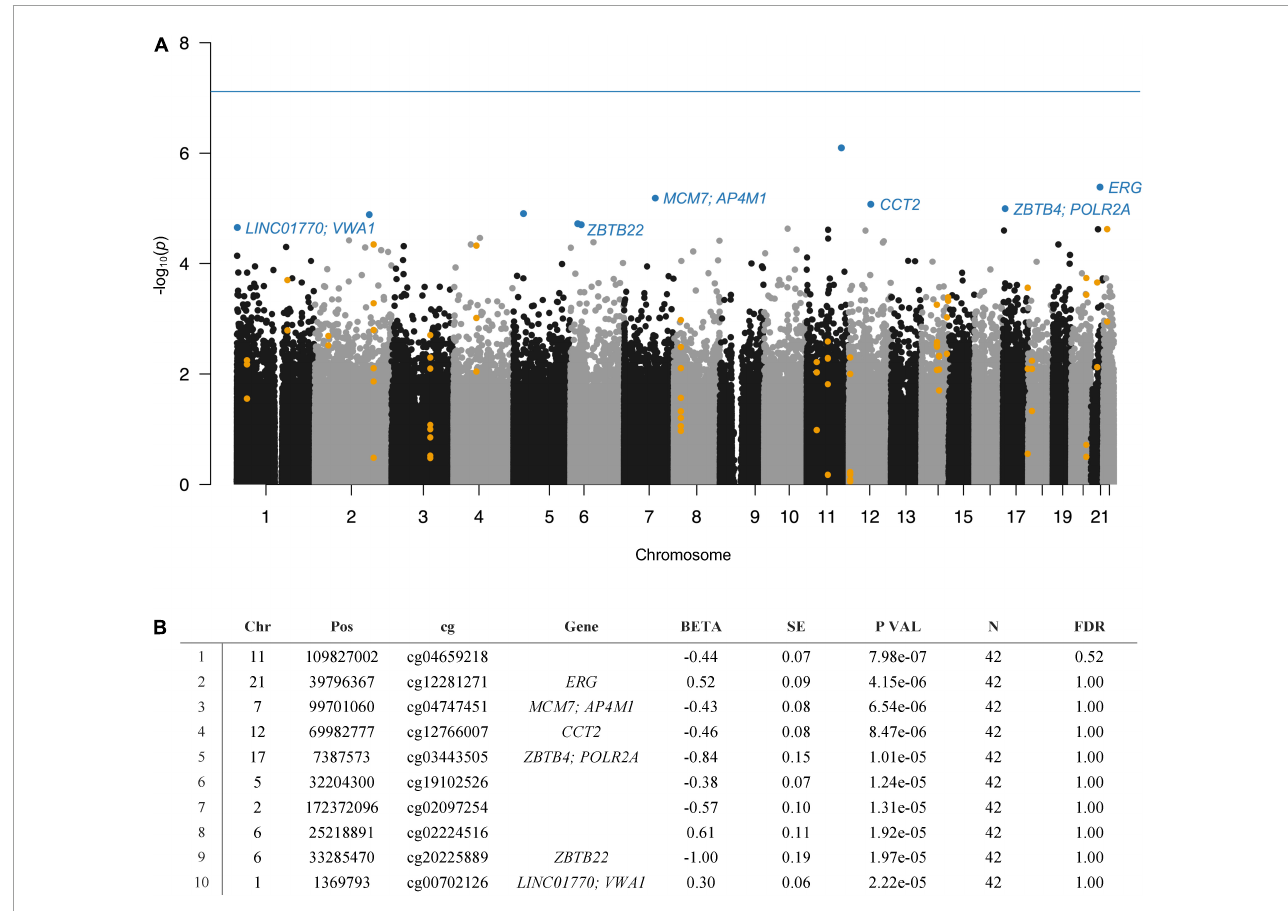
FIGURE1 Results of the EWAS of CUD assessing N = 654,448 cytosine-phosphate-guanine (CpG) sites in N = 42 post-mortem human brain samples from Brodmann area 9 (BA9). (A) In the Manhattan plot, the 10 CpG sites displaying the strongest association with CUD status were highlighted in blue and were annotated to gene name if available. The 20 CUD-associated DMRs are highlighted in orange. The solid blue line depicts epigenome-wide significance ( p < 7.64e–08). (B) EWAS summary statistics for the 10 CpG sites showing the strongest association with CUD